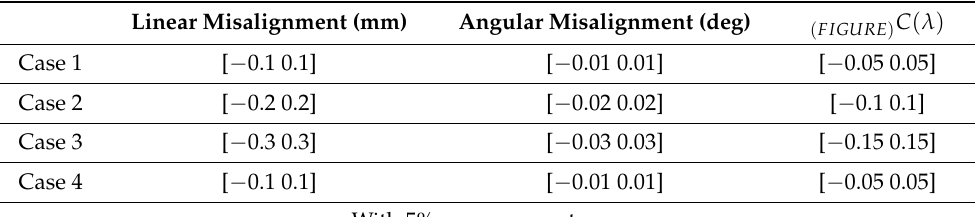
Table 3. Perturbation ranges of misalignments and figure errors. Linear Misalignment (mm) Angular Misalignment (deg) ( FIGURE ) C ( λ